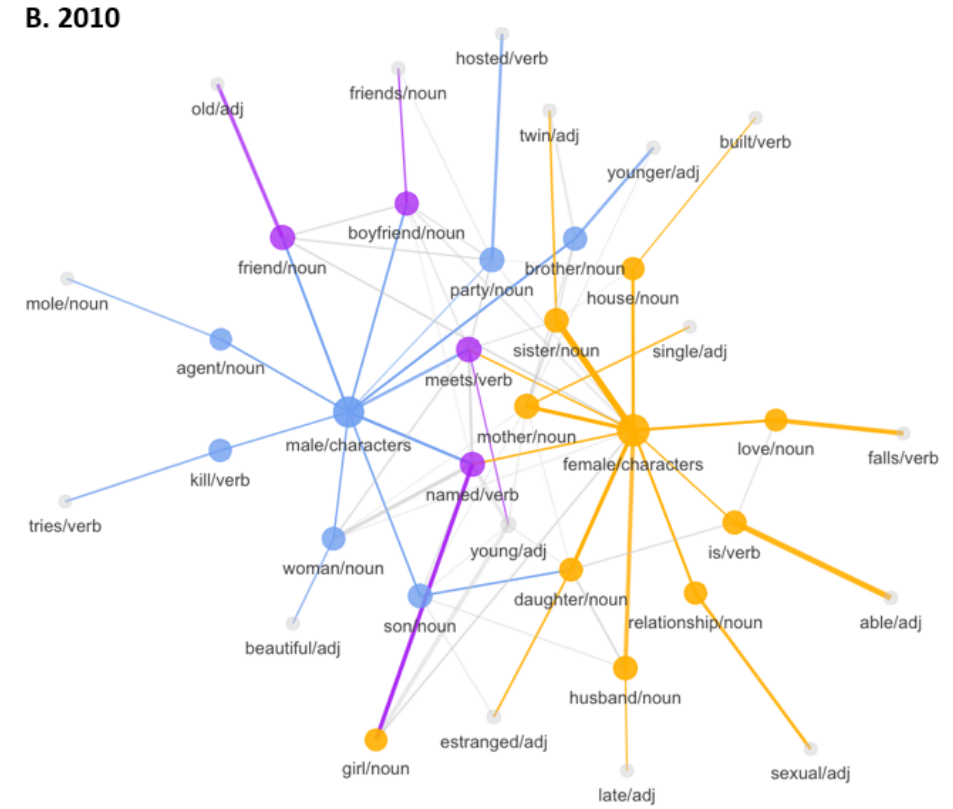
Figure 6. A comparison of significant tropes in the 1940s ( A ) and 2010s ( B ). Some key differences between the tropes from these two decades include the disappearance of the marriage trope in the female characters’ network between the 1940s and the 2010s, and the new addition of a trope related to sexual relationships. For male characters, while there were no crime-related tropes in the 1940s, there was one in the 2010s.